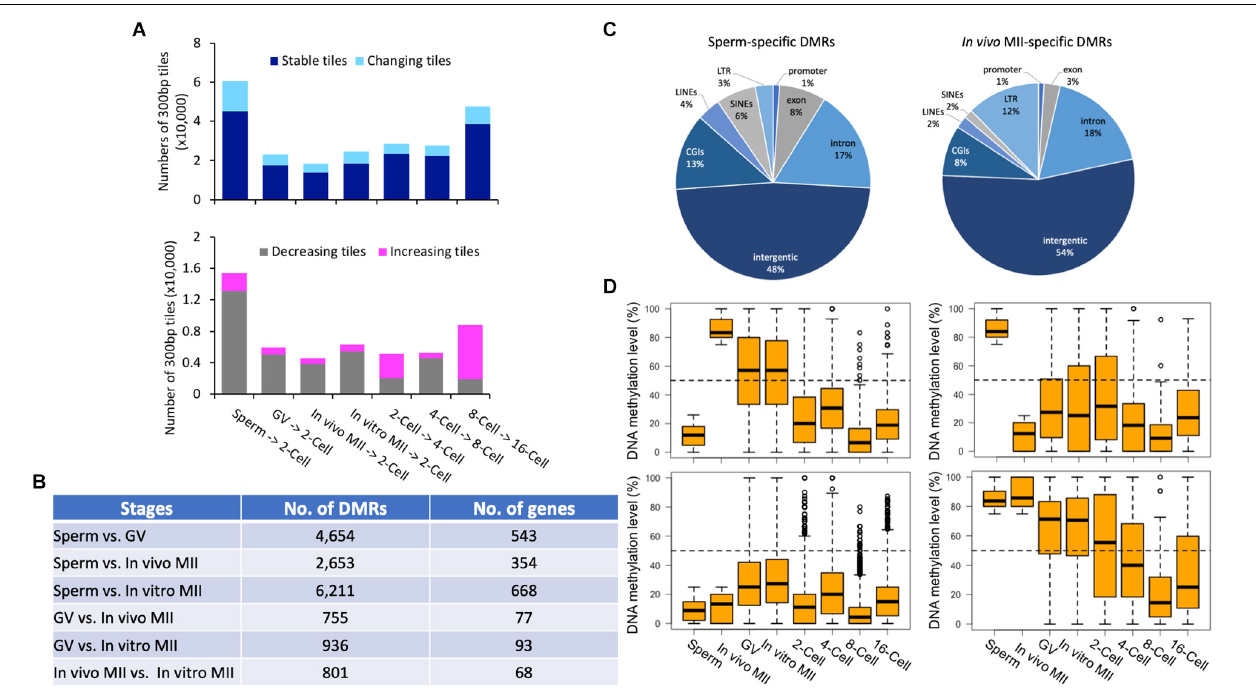
FIGURE 4 | Pairwise comparisons of methylomes between consecutive development stages and DMRs in gametes. Histogram (A) of the numbers of stable (dark blue) and changing (sky blue) tiles between consecutive stages. Histogram of the numbers of decreasing (gray) and increasing (pink) tiles between consecutive stages. The numbers (B) of DMRs and corresponding genes between gametes of different types. Pie plots (C) of the distribution of in vivo MII- and sperm-specific DMRs in annotated genomic regions. Box plots (D) of DNA methylation levels of oocyte- (upper left) or sperm- (upper right) specific DMRs in gametes and early embryos, as well as distributions of tiles hypomethylated ( ≤ 25%; bottom left) and hypermethylated ( ≥ 75%; bottom right) tiles in both gametes in each development stage. GV, germinal vesicle oocytes; MII, matured